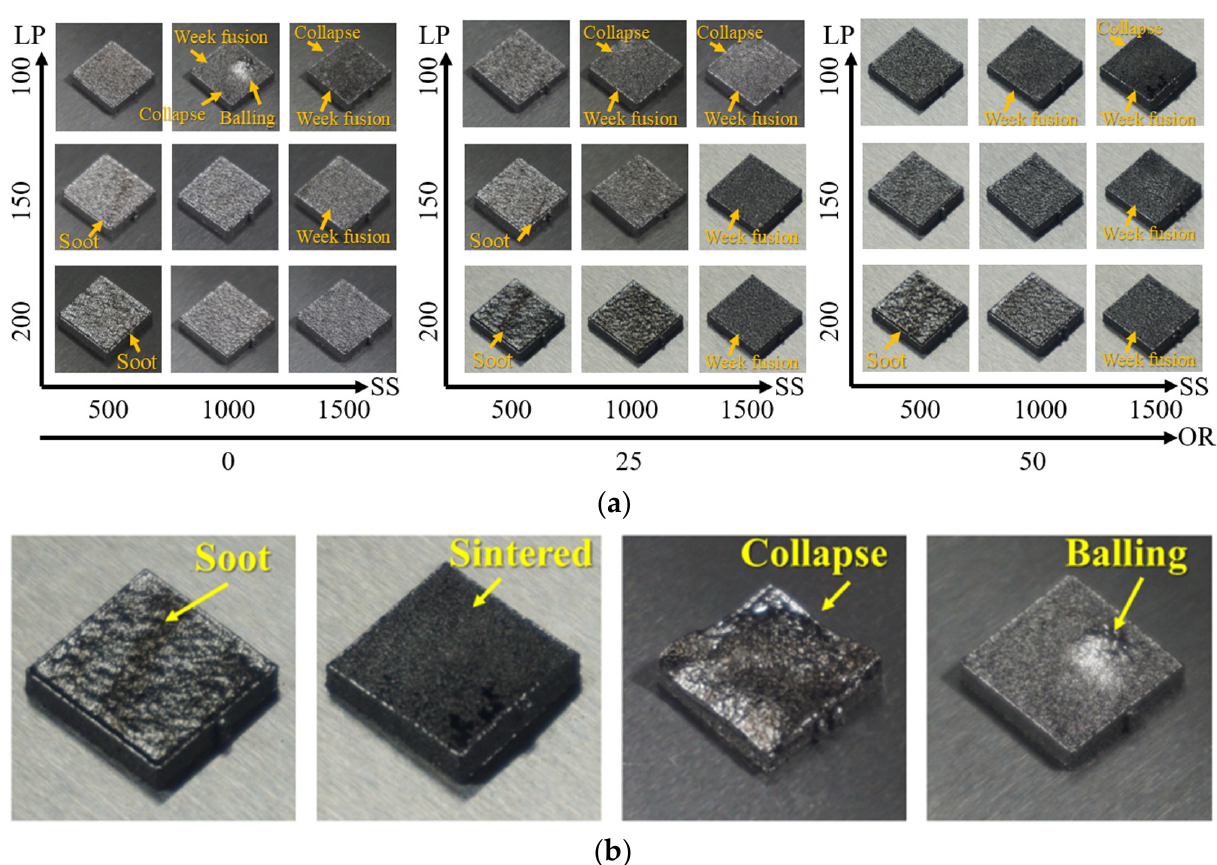
Figure 6. Deposition results according to process parameters: ( a ) morphology of deposited ASTM 316L specimen according to process parameters and ( b ) surface defect mode of deposited speci- mens.